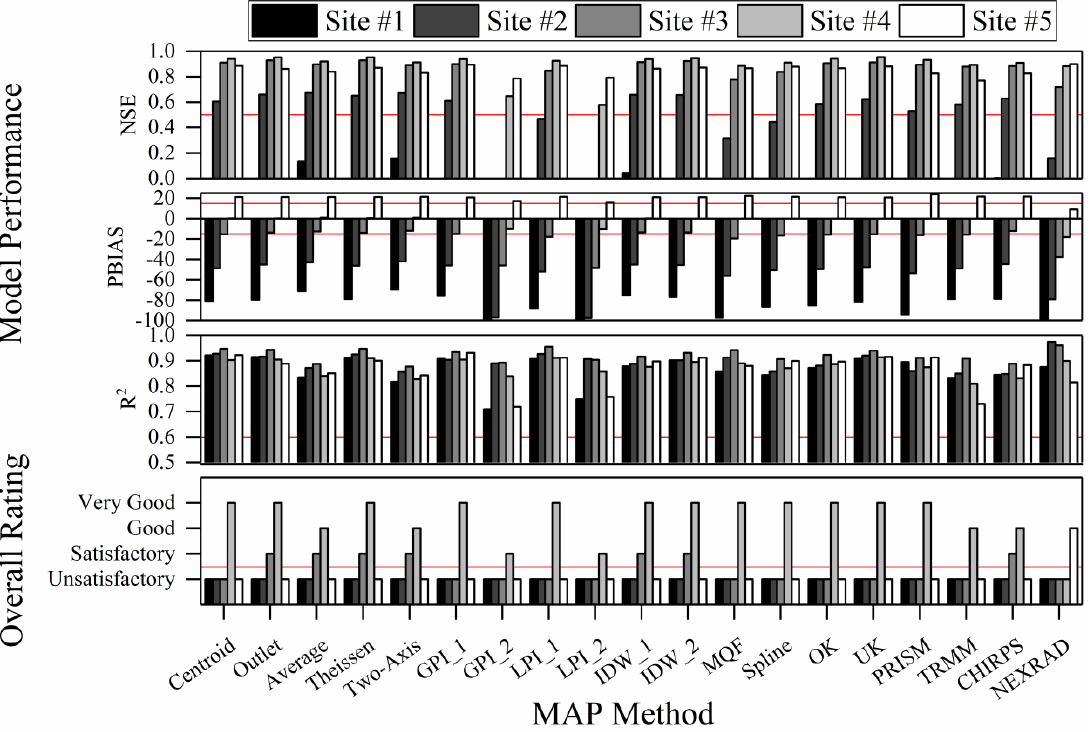
Figure 4. Mean areal precipitation (MAP) input effects on calibrated hydrological model performance criteria and overall performance ratings for SWAT model simulated annual streamflow at five gauging sites (gray-scale columns) located in the Hinkson Creek Watershed, Missouri, USA. The red lines show “Satisfactory” model performance thresholds. PBIAS values smaller than − 100 were not shown.